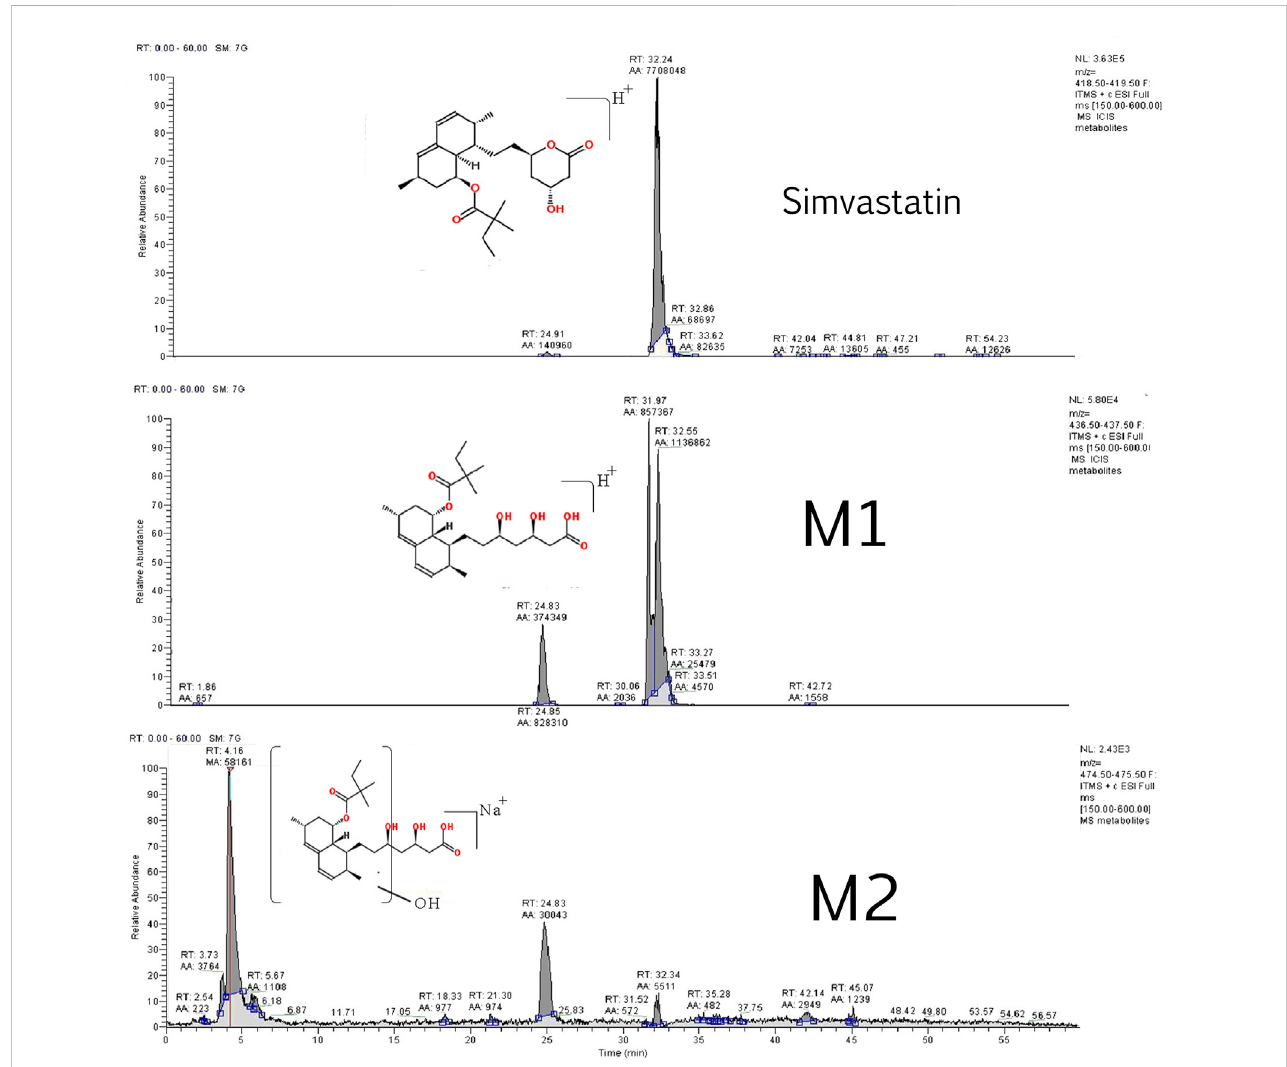
FIGURE 4 Representative extracted ion chromatograms for simvastatin and its metabolites M1 and M2.